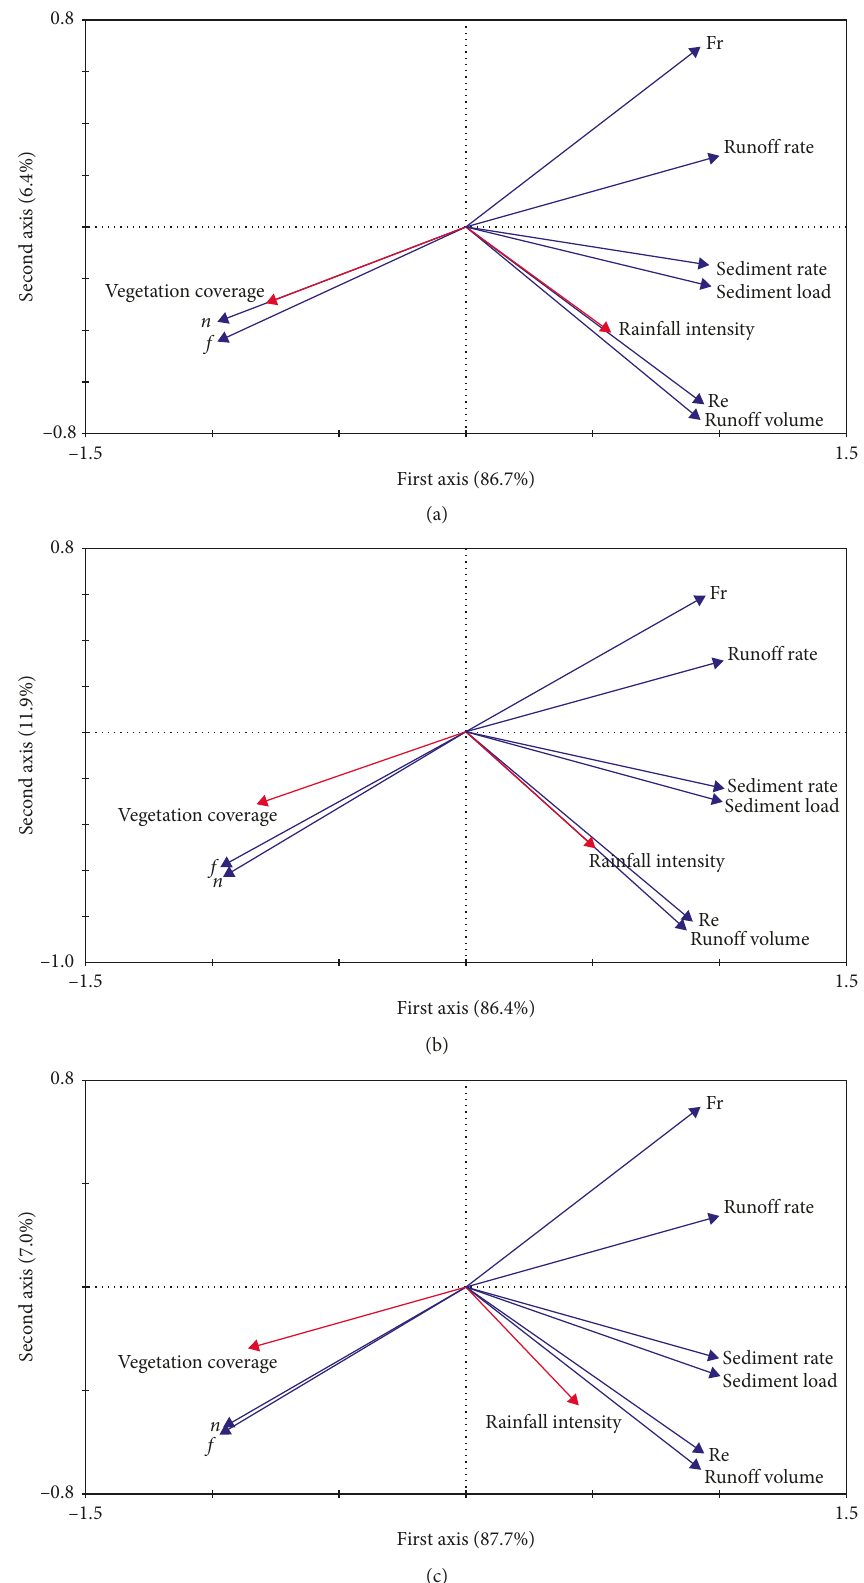
Figure 6: Ordination axes 1 and 2 of the RDA for runoff characteristics, vegetation coverage, and rainfall intensity. (a) Cynodon dactylon . (b) Indigofera amblyantha . (c) Cynodon dactylon and Indigofera amblyantha